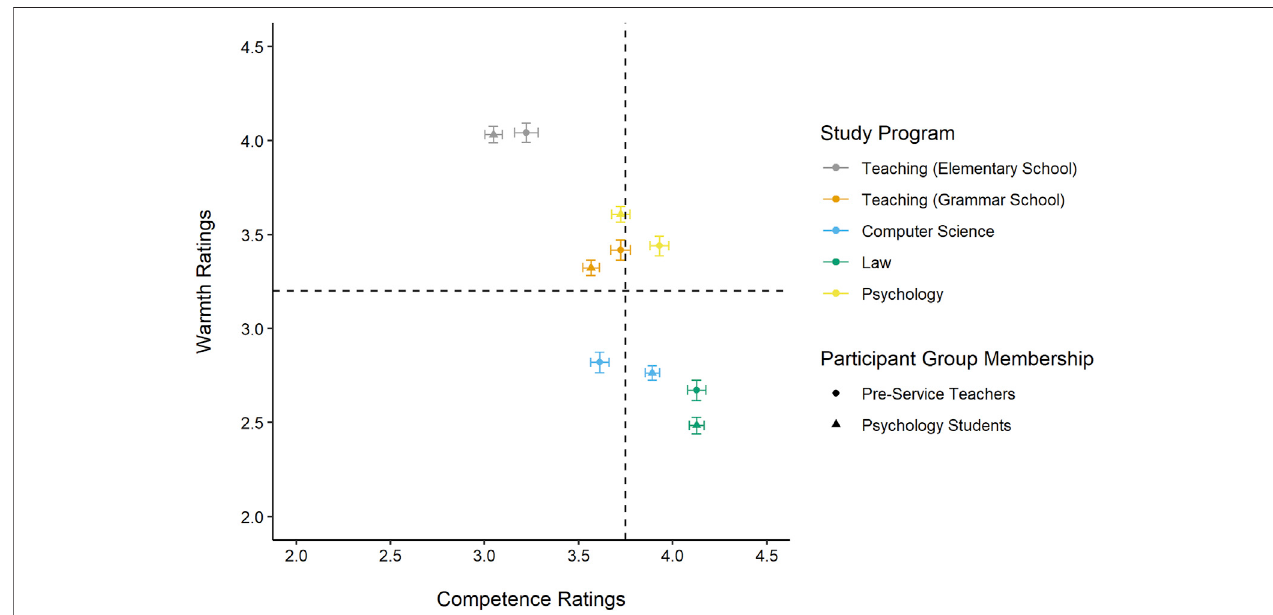
FIGURE 1 | Competence and Warmth Ratings by Study Program and Participant Group Membership in Study 1. Note. Mean competenceand warmth ratings for different study programs on a scale from one to fi ve are shown for participants belonging to the groups of pre-service teachers and psychology students. Error bars represent standard errors. Dotted lines represent the medians of the competence and warmth